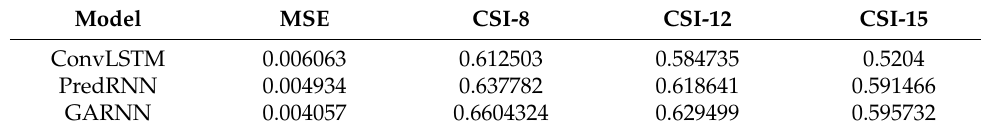
Table 1. Quantitative results comparison of GARNN, ConvLSTM, and PredRNN.